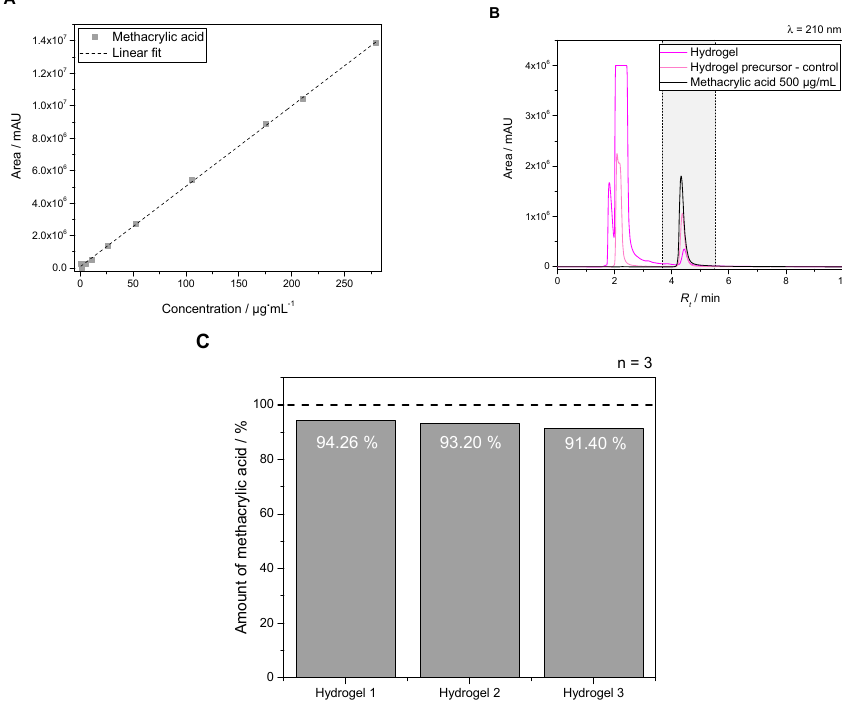
Figure 4. Determination of methacrylic acid units for degree of modification as well as incorporation of functions for gelation. High-performance liquid chromatography (HPLC) was used as method for quantification. Calibration curve of methacrylic acid standards ( A ) as well as a chromatogram ( B ) showing hydrogel, control and standard profile. Furthermore, the total amount per PEG-PLLA–based hydrogel was in the range of 92.95% ± 1.45 ( C ). Materials 2018 , 11 , x FOR PEER REVIEW